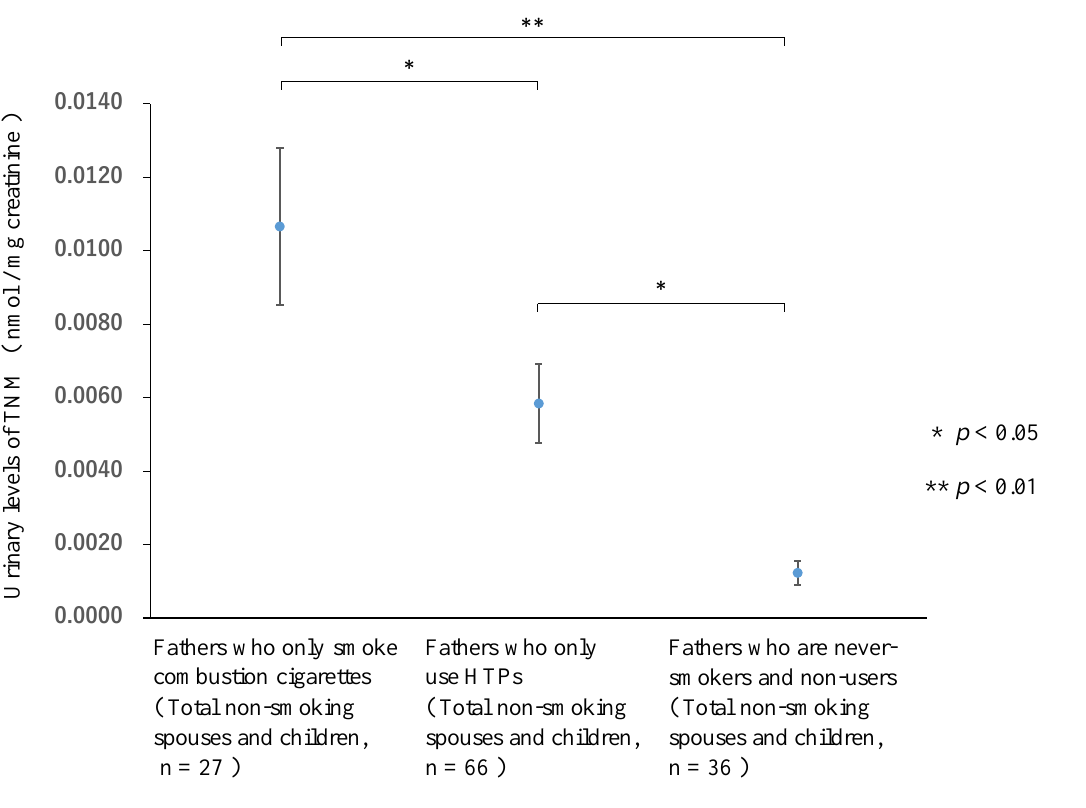
Figure 1. Comparison of total nicotine metabolite (TNM) urinary levels after creatine normalization among the three groups. (conc. Creatine).